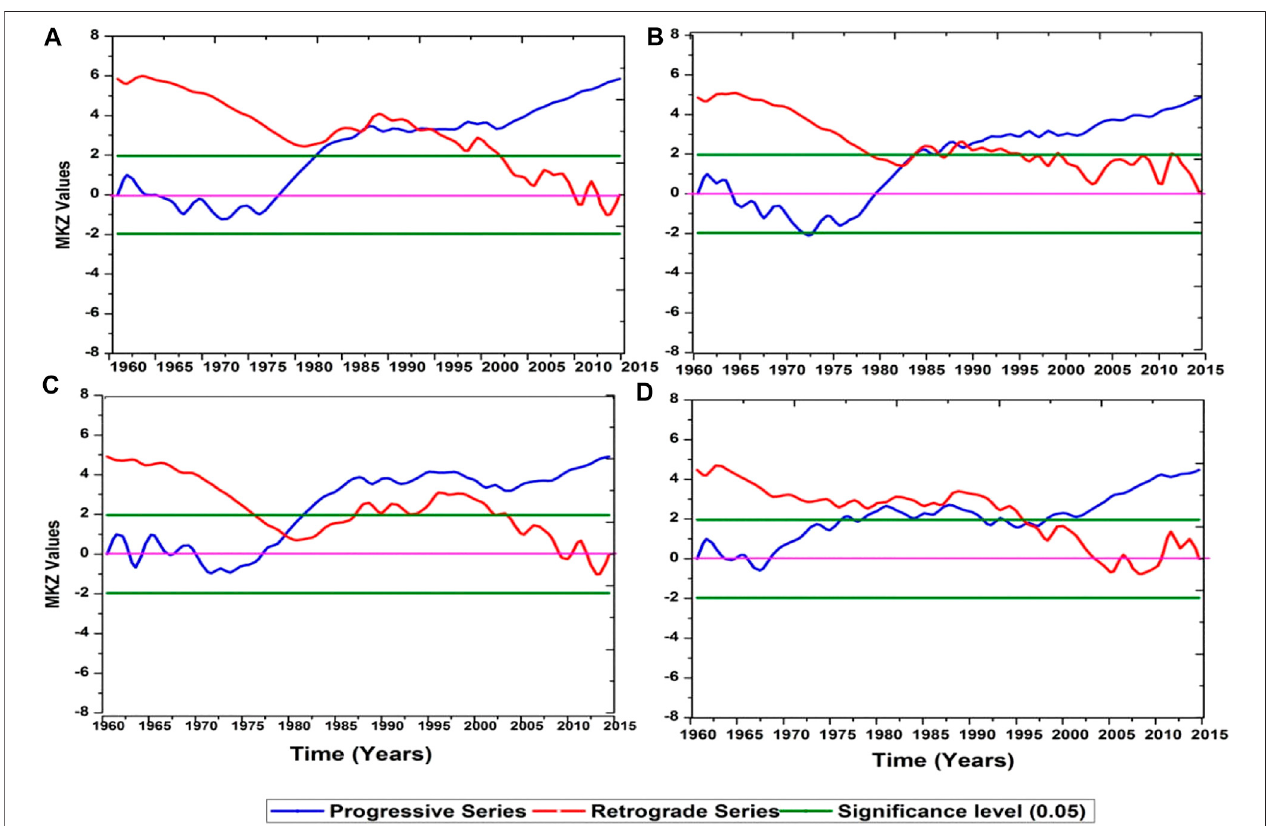
FIGURE 7a | Abrupt change of annual and seasonal Tmax over Rwanda during the period of 1961 – 2014; (A) Annual, (B) March – May season, (C) June – August, (D) October – December.